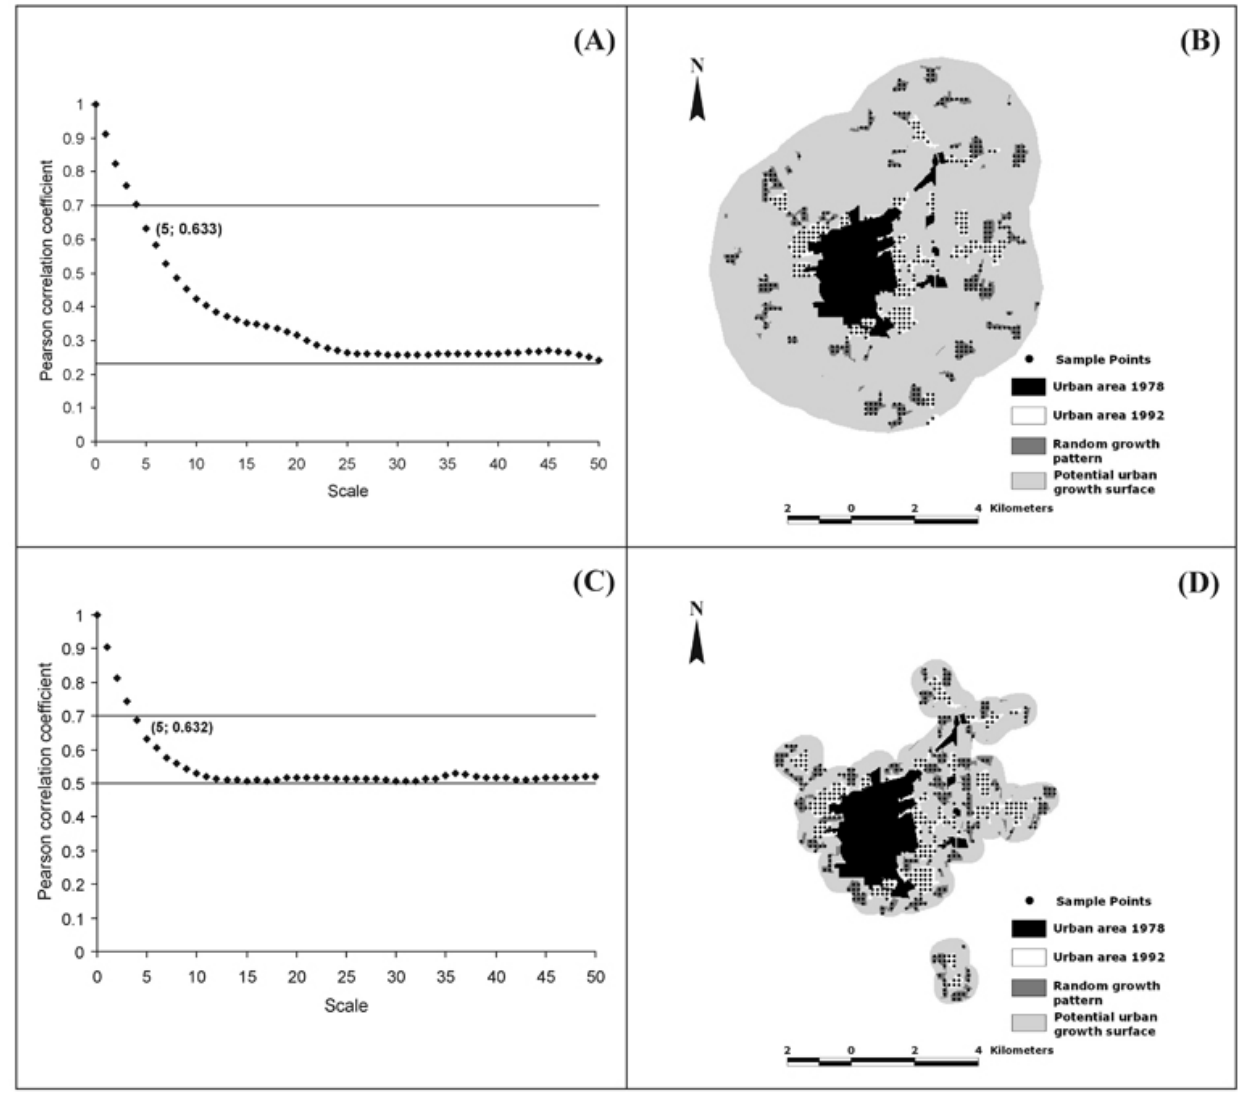
Fig. 3. (A) Spatial autocorrelation and scale definition for the 3000-m urban growth surface and (B) systematic sampling of 5 × 5 cells used as the dependent variable based on the 3000-m urban growth surface. (C) Spatial autocorrelation and scale definition for the 500-m urban growth surface and (D) systematic sampling of 5 × 5 cells used as the dependent variable based on the 500-m urban growth